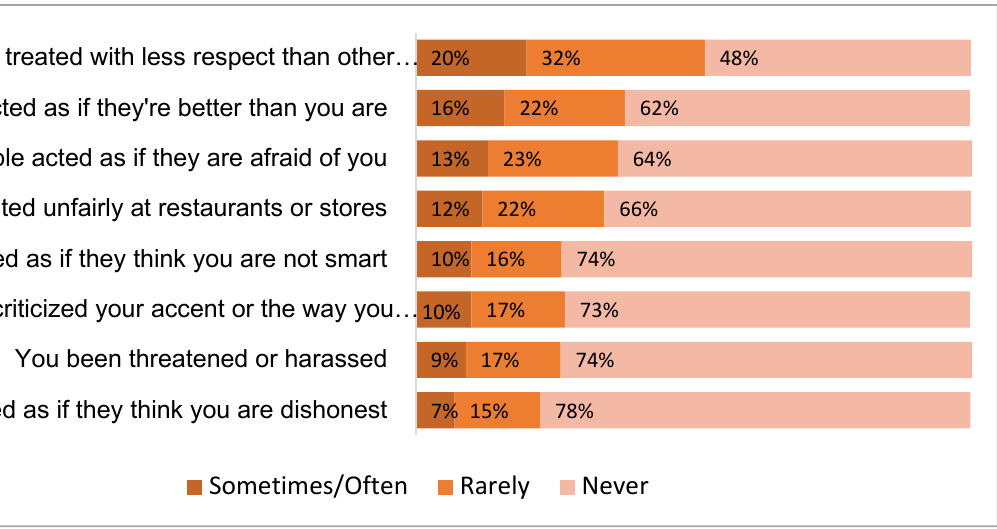
Figure 1. Experiences of discrimination during the COVID-19 pandemic due to being Asian, Asian American or Pacific Islander.